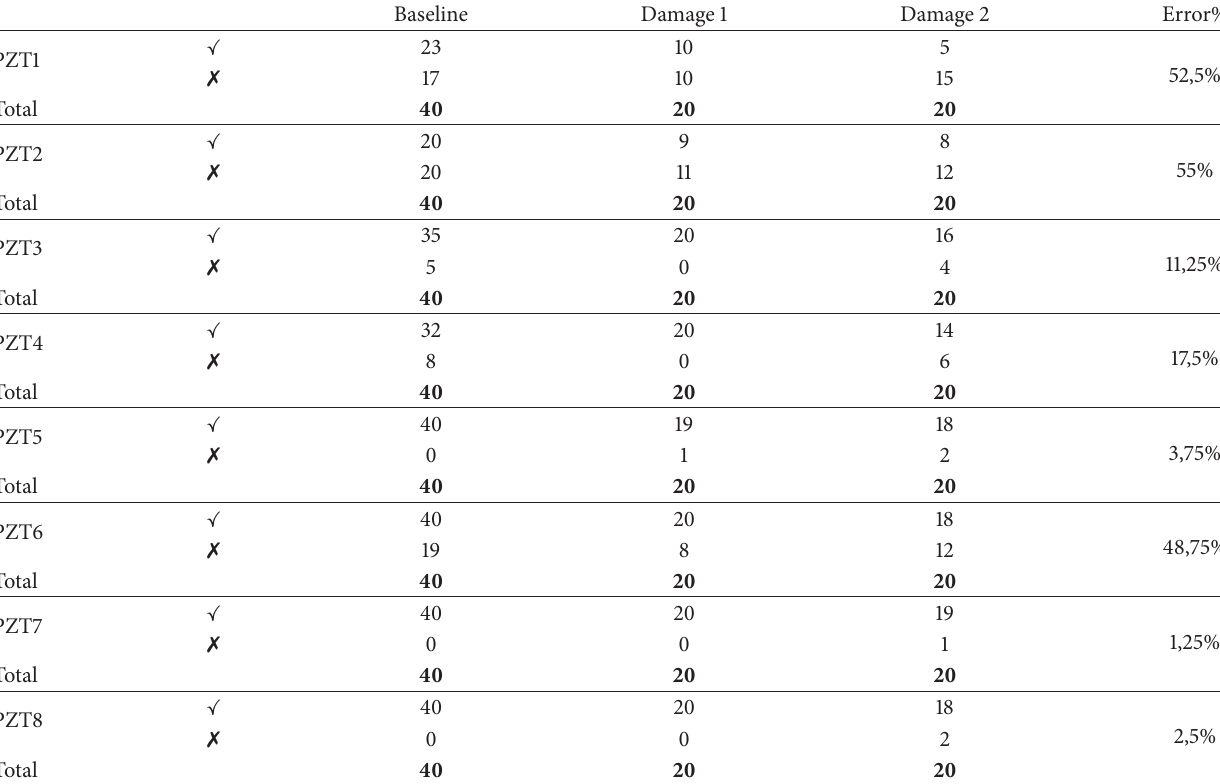
Table 3: Classification of test set of probabilistic neural networks for each PZT patch in the aircraft panel. Baseline